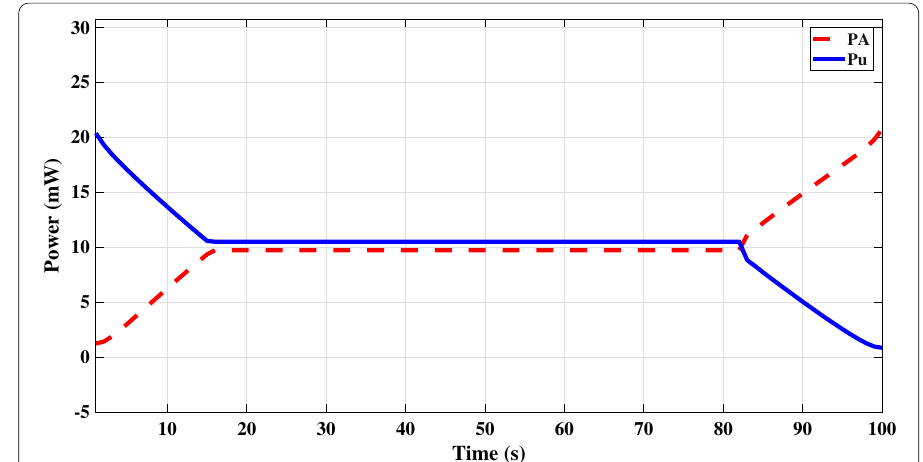
Fig. 11 Power allocation by jointly optimizing power and trajectory